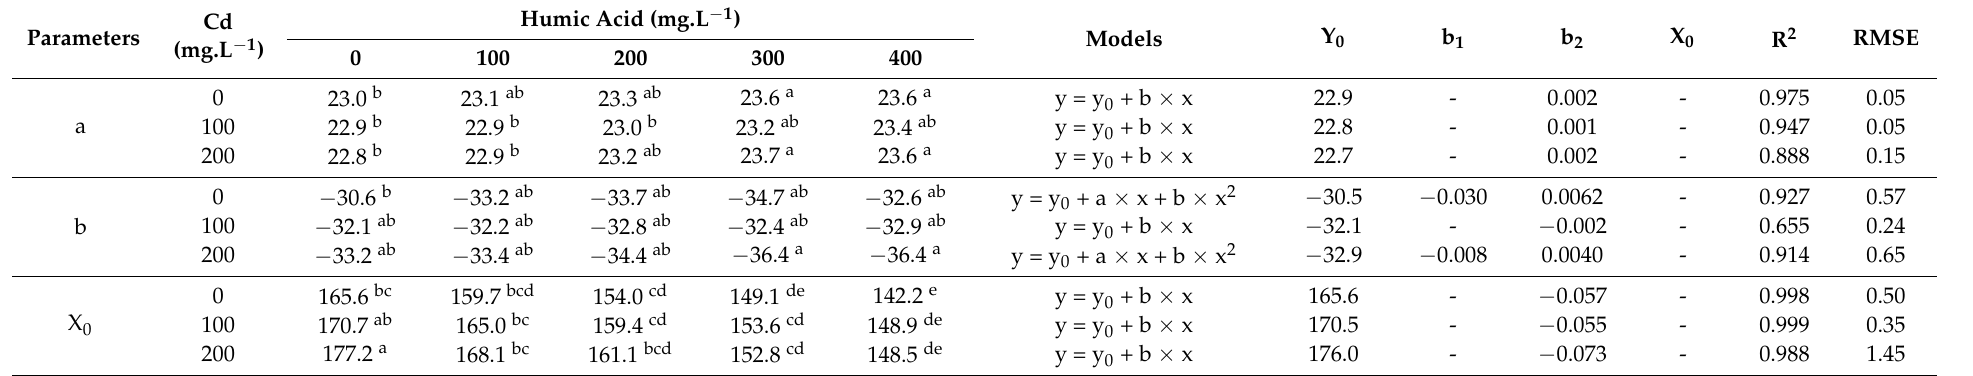
Table 2. Estimated parameters of protein stimulation in pumpkin seeds ( Cucurbita pepo L.) influenced by humic acid under Cd stress.